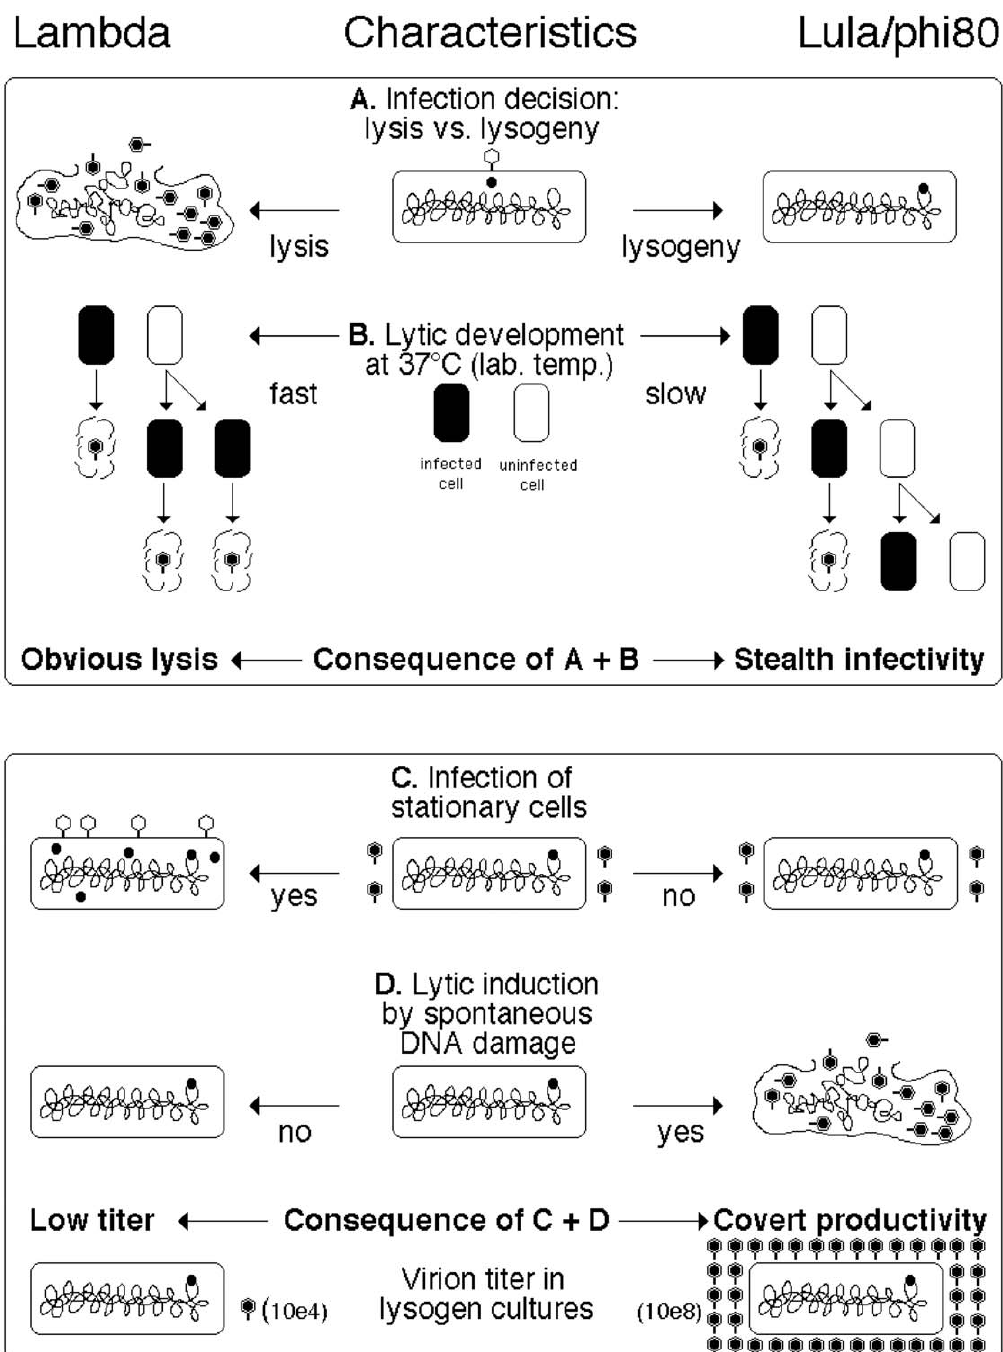
Figure 6. Characteristics of Lambda and Lula/phi80 contributing to their different levels of spread in laboratory environment.